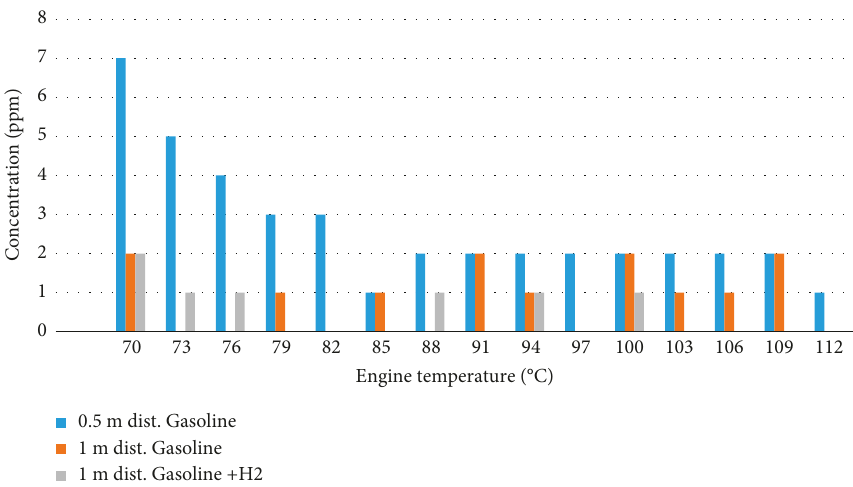
Figure 3: H 2 S exposure at 0.5m and 1m distances at 3000rpm engine speed.